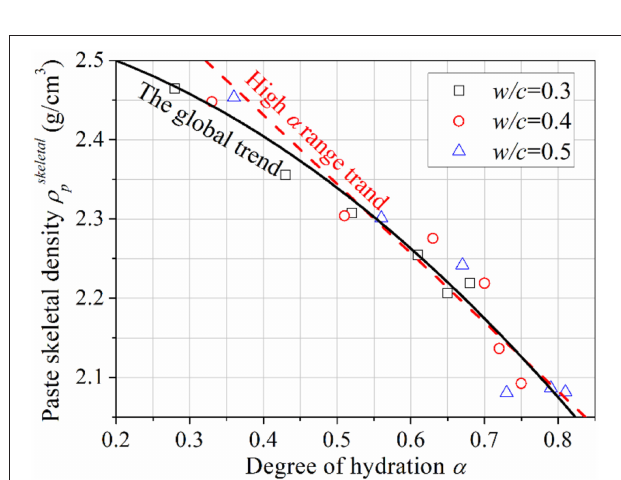
FIGURE 3 | Evolution of paste skeletal density following degree of